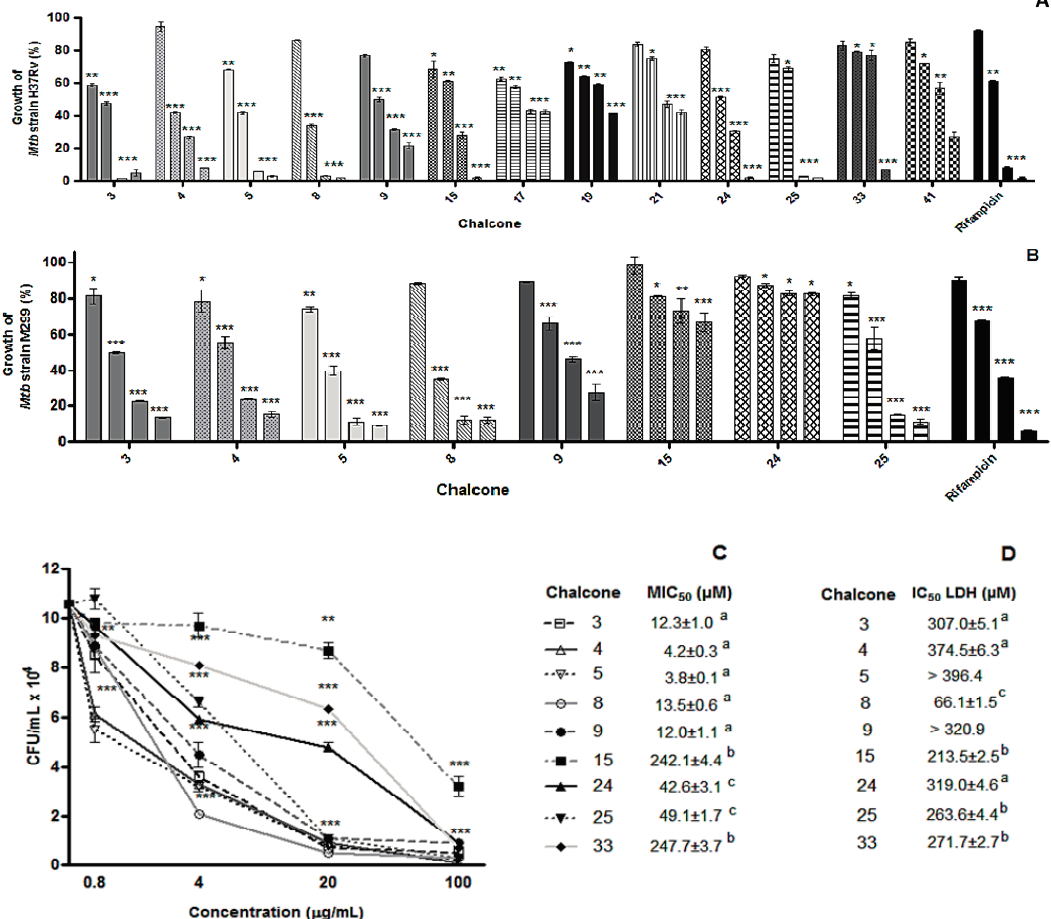
Figure 3. Effect of chalcones on M. tuberculosis growth in bacterial culture and macrophages. Bacterial suspensions (1 × 10 6 CFU/well) of M. tuberculosis strain H37Rv ( A ) and clinical isolate M299 ( B ) were treated or untreated with chalcone samples (0.8, 4, 20 and 100 µg/mL) or rifampicin (0.00032, 0.0016, 0.008, 1 µg/mL for the strain H37Rv and 0.008, 0.04, 0.2 and 10 µg/mL for the strain M299) for 5 days. Bacterial growth in the resulted cultures was quantified by MTT test. Data are presented as a percentage of bacterial growth of each treated culture compared to the growth of corresponding untreated culture (100%). The four bars for each compound refer to concentrations tested in ascending order. Bacterial suspensions treated with antibiotic rifampicin were used as a positive control. Untreated bacterial suspension served as a negative control. ( C , D ) RAW 264.7 macrophages were infected with M. tuberculosis strain H37Rv at the infection ratio of 1:1 (macrophage:mycobacteria) and treated with chalcones for 4 days . Bacterial intracellular viability after the treatment was determined by bacterial CFU counts (C) and toxicity for macrophages was evaluated by LDH assay (D). The results presented are mean values obtained over three experiments, each done in triplicate. *** p < 0.001, ** p < 0.01 and * p < 0.05 compared to untreated group. Values in the same column with different superscript letters (a–c) are significantly different ( p < 0.05 or p < 0.001; determined by Tukey